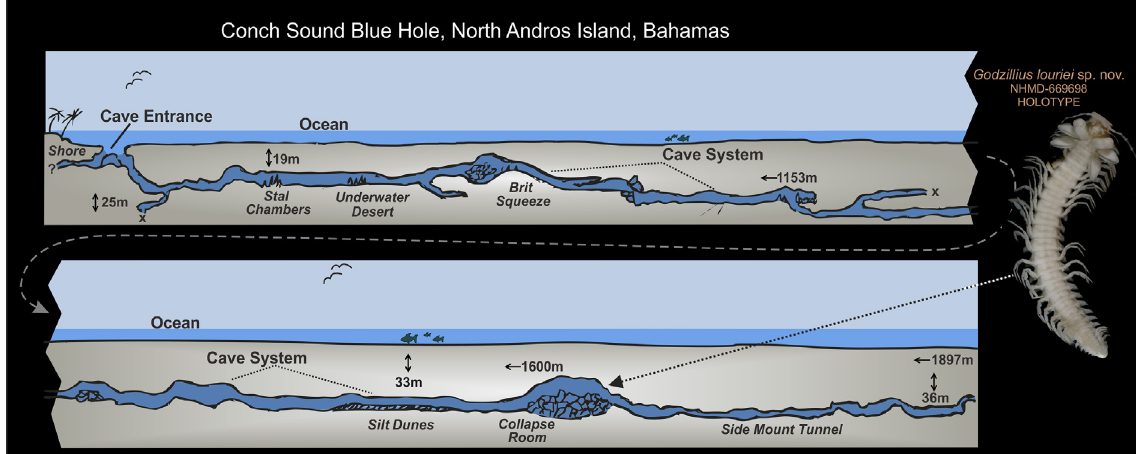
Fig. 2. Cave profile of Conch Sound Blue Hole, North Andros Island, the type locality of Godzillius louriei sp. nov. Sampling of G. louriei sp. nov. occurred in the “Collapse Room” at approximately 1600 m. Abbreviations: x = chambers too small for diver entry; ? = undescribed/unexplored